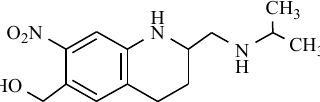
Figure 14. The chemical structure of anthelmintics: ( a ) Niclosamide; ( b ) Nitroxynil; ( c ) Niclofolan; ( d ) Netobimin; ( e ) Disophenol; and ( f ) Nitrodan.